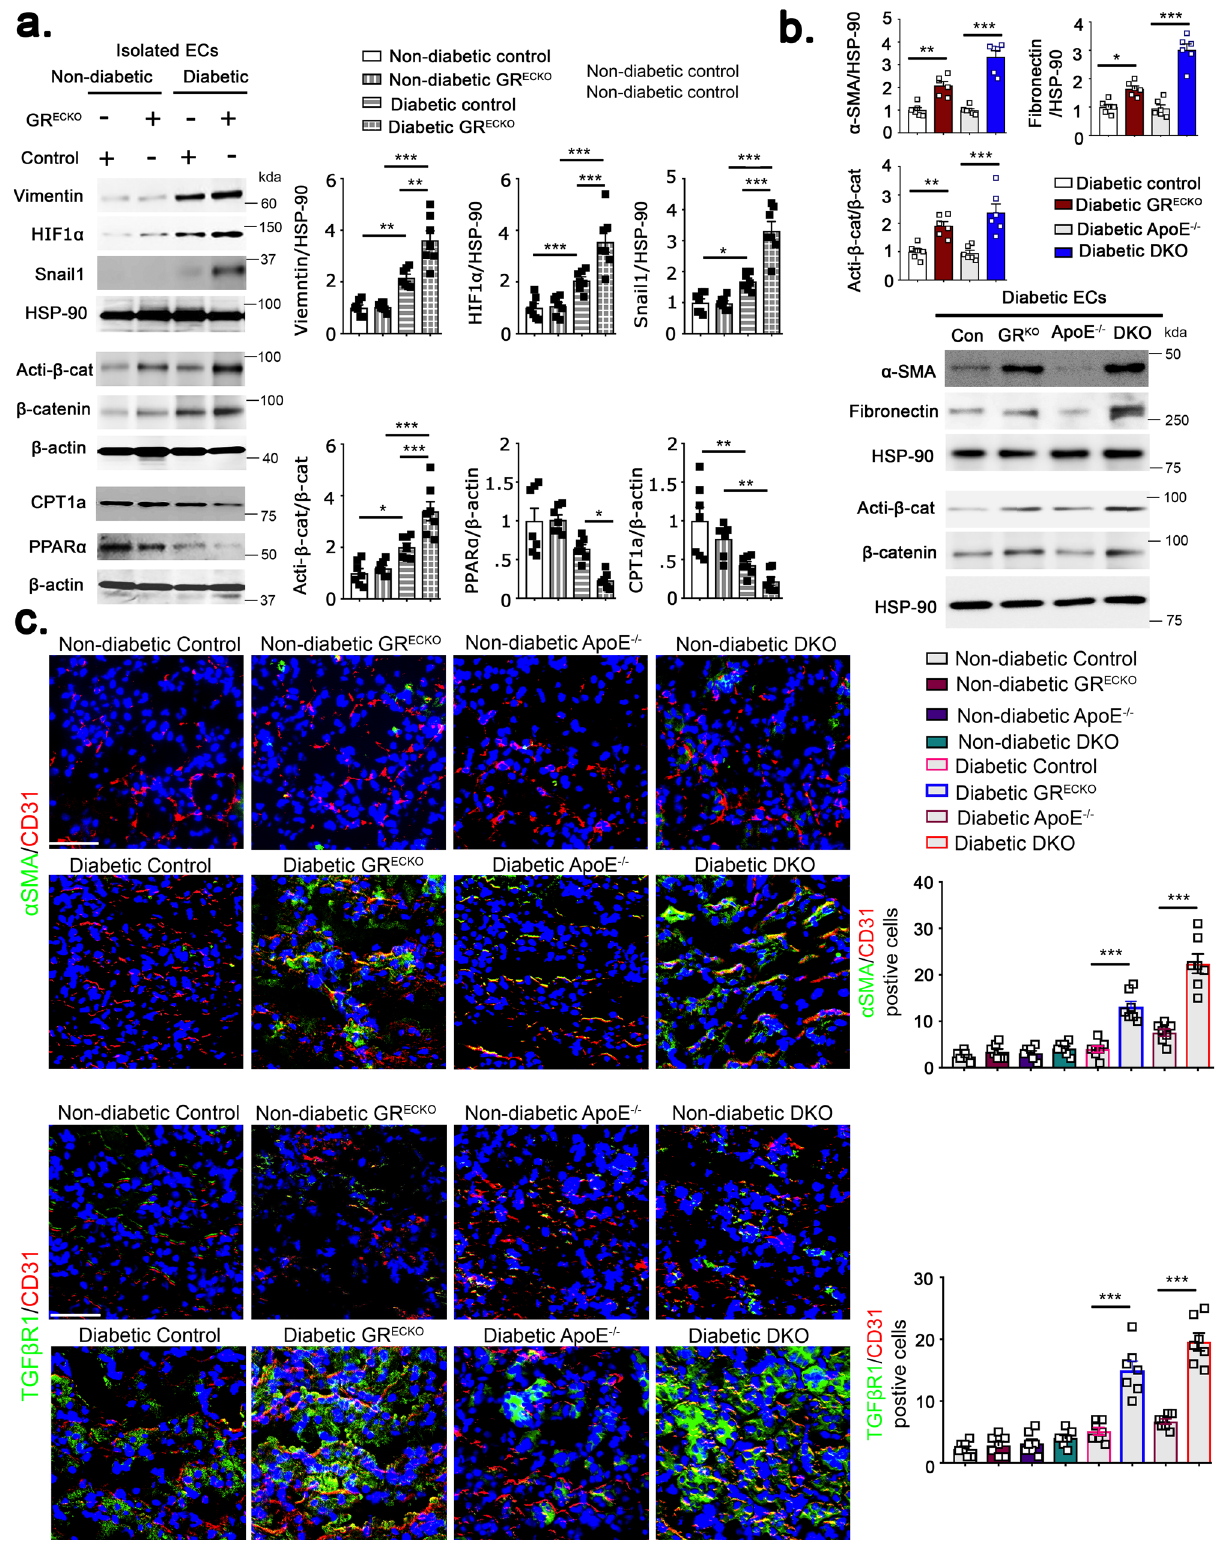
d depicts the schematic diagram showing the experimental pro- tocol for LGK974 treatment in diabetic CD-1 and UUO mice. LGK974 greatly diminished the ECM deposition, relative area of fi brosis, collagen accumulation, and glomerulosclerosis in both models used (Supplementary Fig. 16e, f). Wnt inhibition also